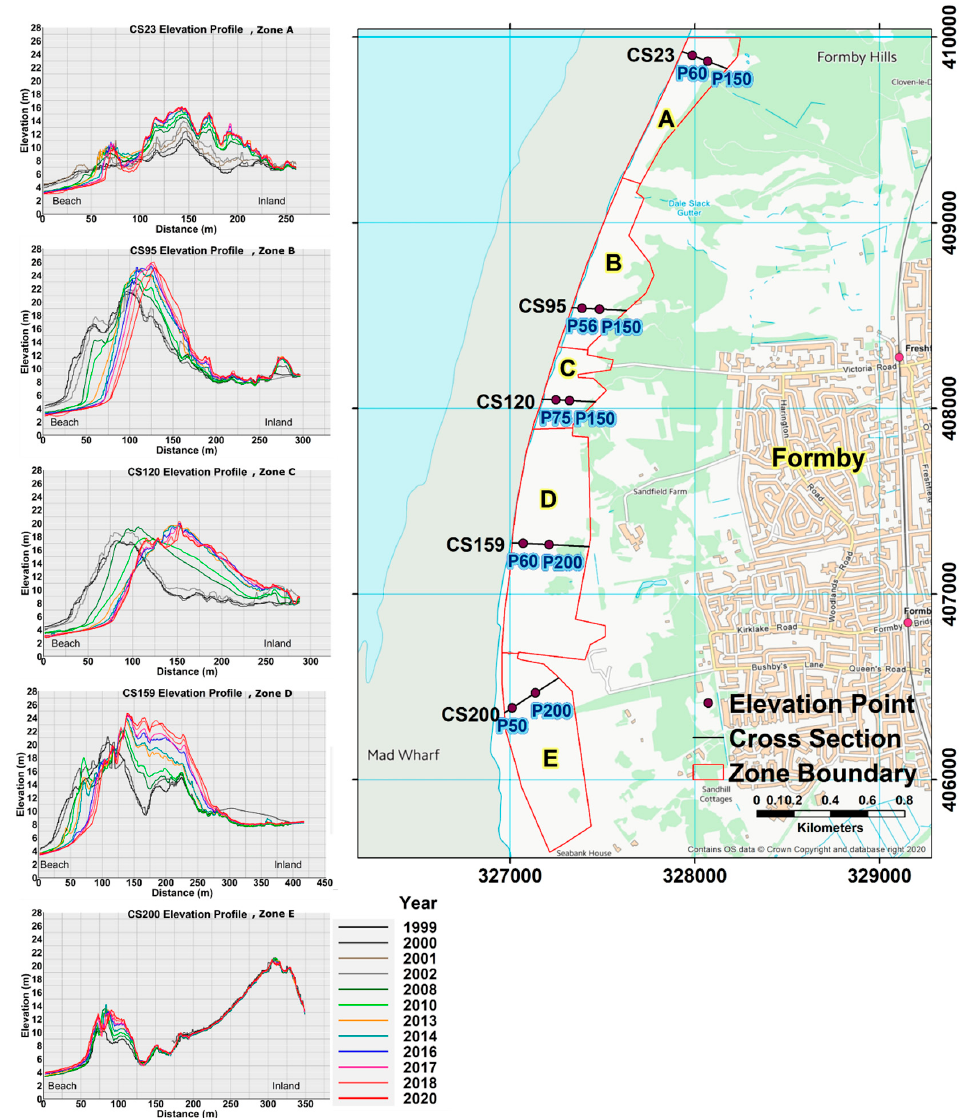
Figure 9. Selected cross section profiles and elevation points from Zones A, B, C, D, and E. The black lines on the map figure show the location of the cross–section profiles. The coloured lines in each profile and legend represent the DTM acquisition from different years. Zones A, B, C, and D show inland horizontal motion of the frontal dunes of about 50 m while Zone E shows a 10 m movement of the frontal dunes in the opposite direction towards the sea.